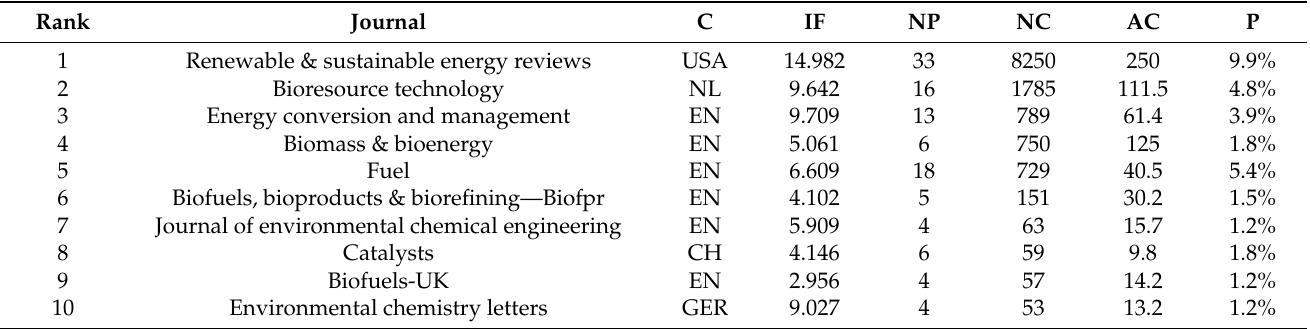
Table 1. Top ten scientific journals with publications in the field of feedstocks for biodiesel